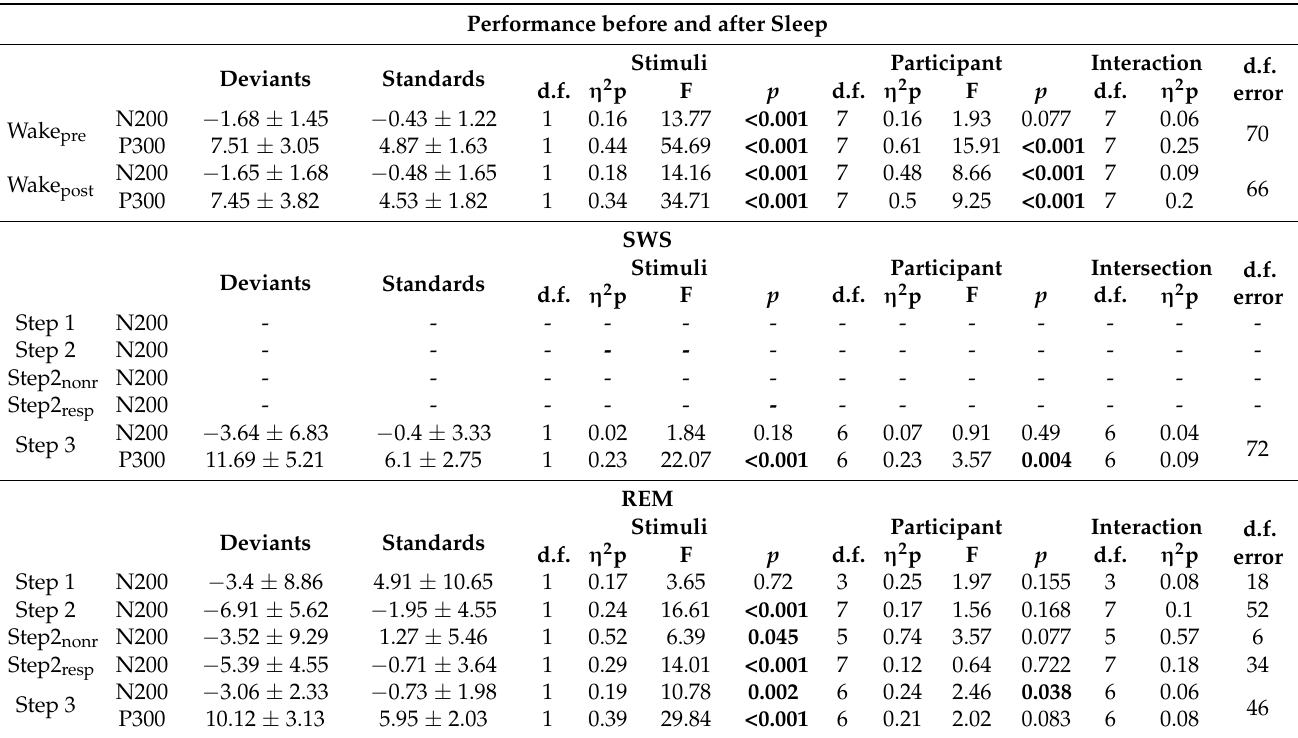
Table A6. Comparison of maximum amplitude difference between sounds for global